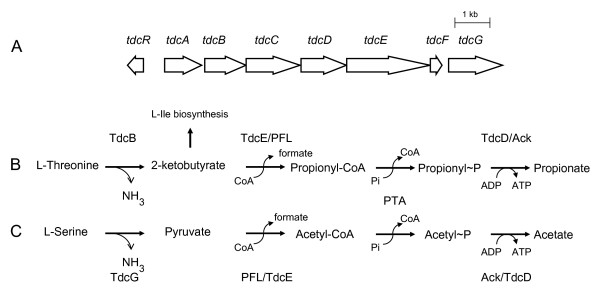
The tdc operon and the pathways for degradation of L-threonine and L-serine. Schematic representation of the organisation of the tdc operon on the chromosome of E. coli and the function of the respective gene products. (A) shows the tdc operon [15], where the tdcA and tdcR gene products are transcriptional regulators, while the tdcC gene product is L-threonine/L-serine permease [30]. Also shown are the metabolic pathways for the anaerobic degradation of (B) L-threonine and (C) L-serine, where: Ack = acetate kinase; PFL = pyruvate formate-lyase; PTA = phosphotransacetylase.